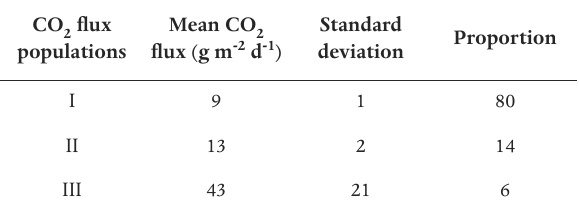
Table 1. Summary statistics for the portioned CO